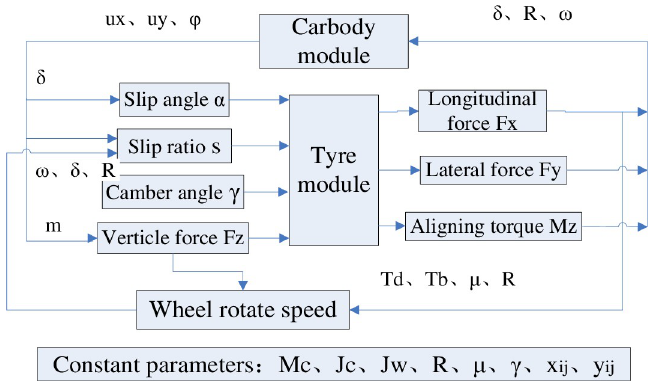
Fig 6. The main system modules of vehicle